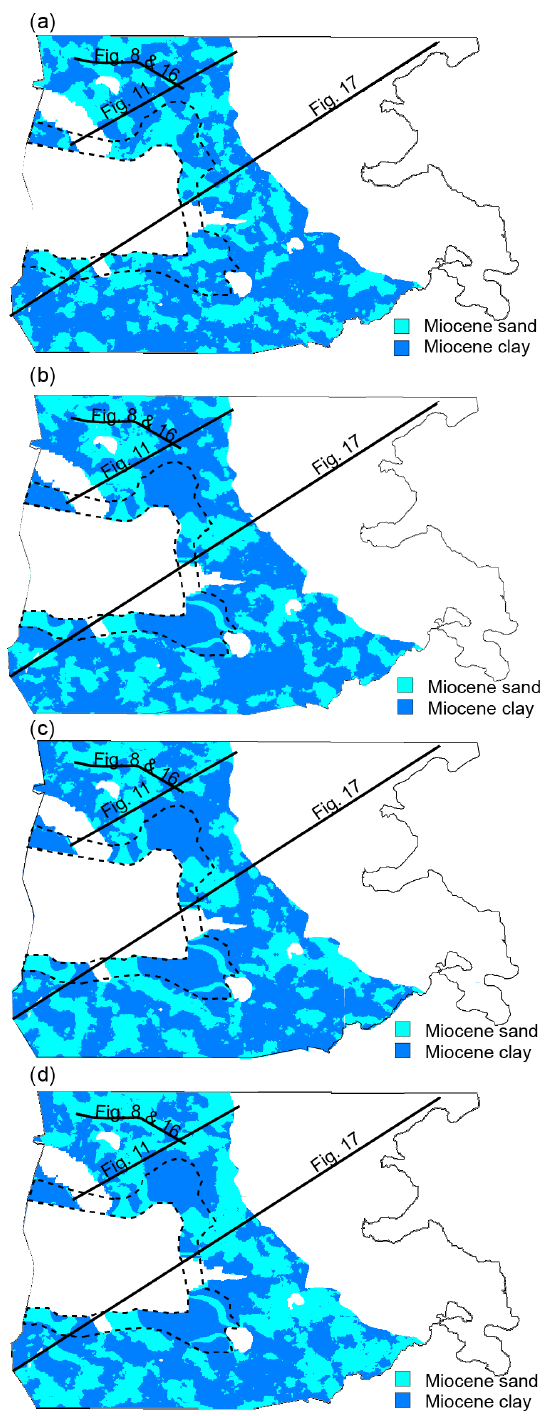
Figure 15. Horizontal slice at elevation − 188m through the real- izations generated by using different conditional strategies (panel a for strategy a in Table 1, panel b for strategy b, panel c for strat- egy c, and panel d for strategy d). Position of the profiles in Figs. 8, 11, 16, and 17 are shown. The dashed region encapsulates the buffer around the Tønder model, which has been used as hard conditioning information in (b, c, d)